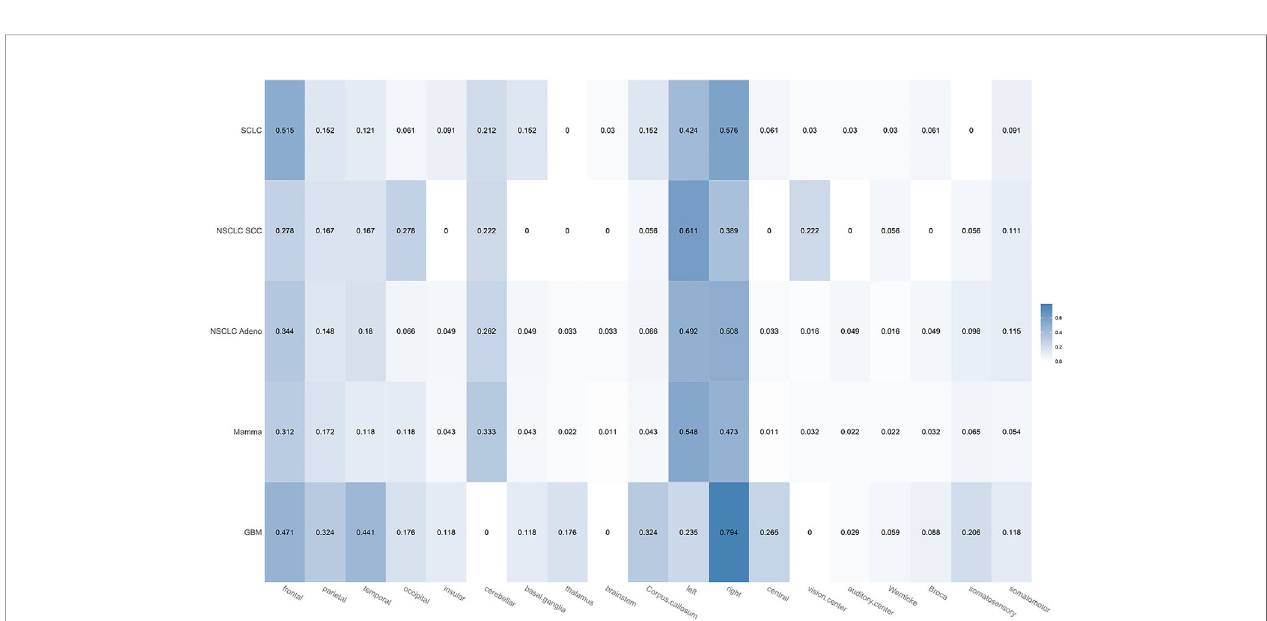
FIGURE 4 | Heatmap showing the proportions for the different localization-based MR features broken down for the different histological subtypes of brain metastases (SCLC, NSCLC SCC, NSCLC adenocarcinoma, mammacarcinoma). Each proportion corresponds to the ratio: number of lesions with feature/total number of lesions of that class. Darker color indicates a larger